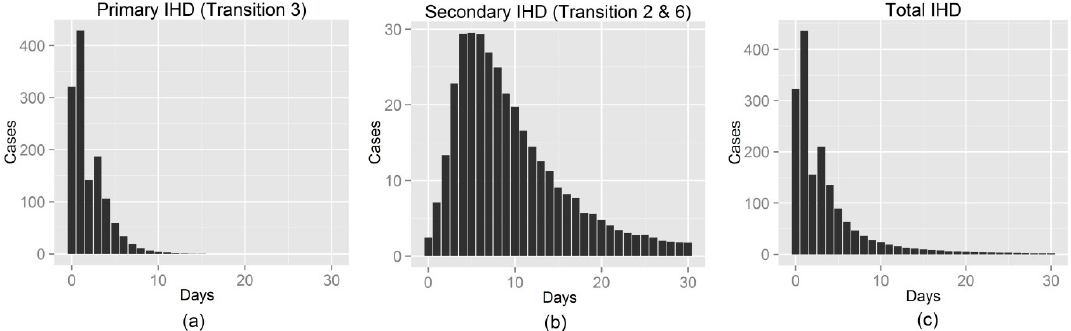
Figure 2. Simulated distributions of time to IHD incidence via: ( a ) the direct pathway (Transition 3); ( b ) the indirect pathway (Transitions 2 + 6); ( c ) Results averaged over 100 simulations of cohorts of 100,000 people.